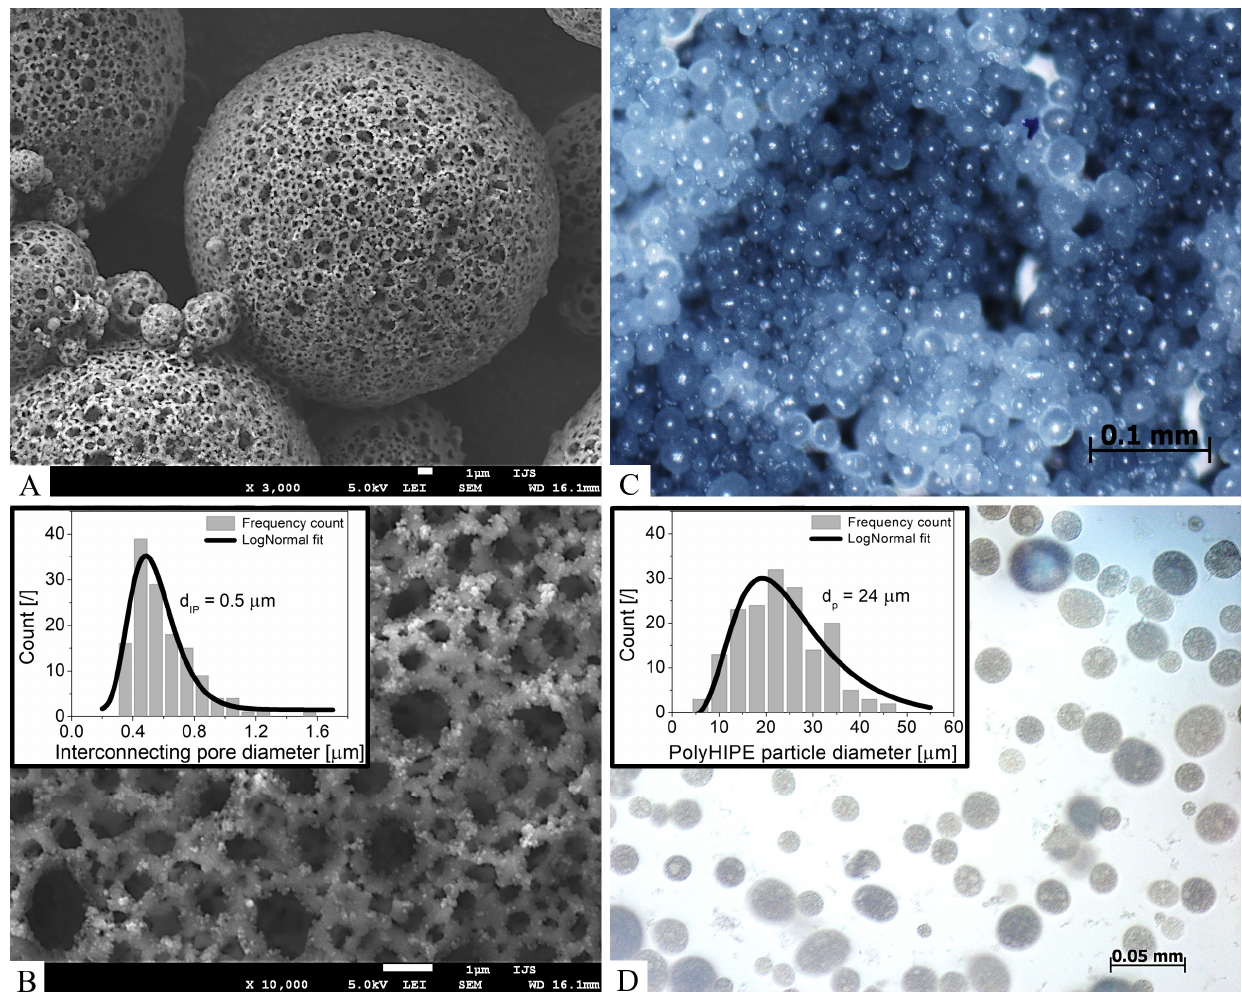
Figure 1. Microscope images of polyHIPE particles with corresponding IP and particle size distributions. On the left are: ( A ) SEM image at 3000 and ( B ) 10,000× magnification used to obtain the IP distribution and mean IP size ( d IP ) shown in the inset in B panel. On the right, optical microscope images used to measure the particle size distribution and mean particle size ( d p ) taken after filtration in an aqueous solution with reflected (( C ) image) and transmitted light (( D ) image). Images were analyzed with ImageJ software, and median IP and particle size were obtained from the LogNormal distribution.